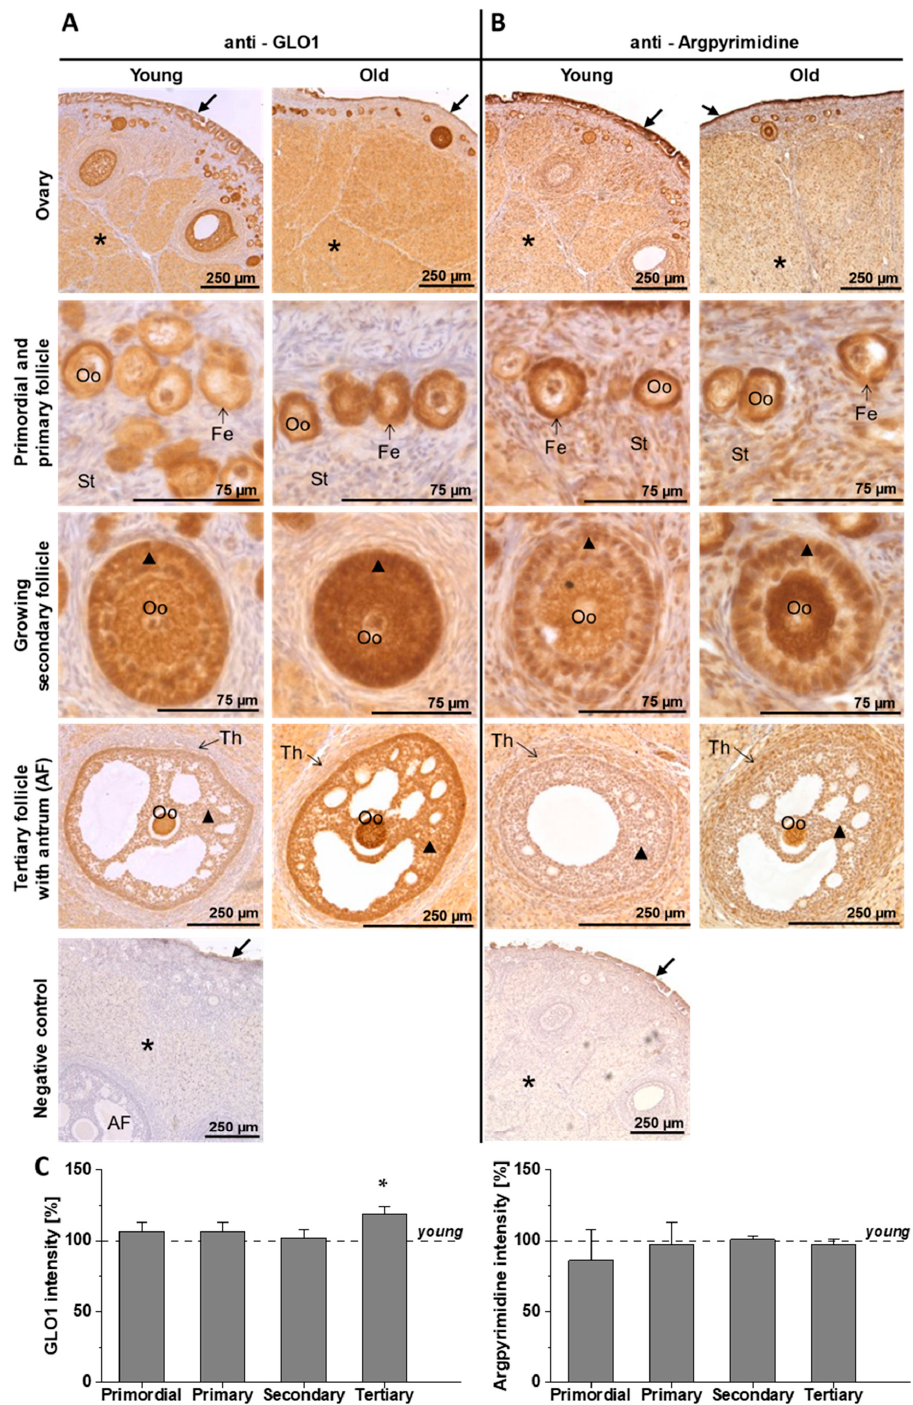
Figure 2. Immunohistochemical analysis of GLO1 ( A ) and argpyrimidine ( B ) in the ovary of young and old rabbits. GLO1 and argpyrimidine were visualised through a peroxidase–diaminobenzidine reaction (brown colour). Nuclei were stained with haematoxylin (blue colour). Oo = Oocyte. Th = Theca folliculi. St = Stromal cells. Fe = Follicular epithelium. → = Germinal epithelium. (cid:78) = Granulosa cells. * = Corpus luteum. ( C ) GLO1 and argpyrimidine staining intensities were evaluated independently and blindly by at least two researchers. Staining was graded using a scale from 0 (none) to 5 (very strong). The diagram depicts the staining intensity by follicle stage, calculated as average of oocyte, follicular epithelium / granulosa cell and theca folliculi grading. Relative intensities are expressed as mean ± SEM in per cent, with young rabbits = 100% ( n = 6; * p =